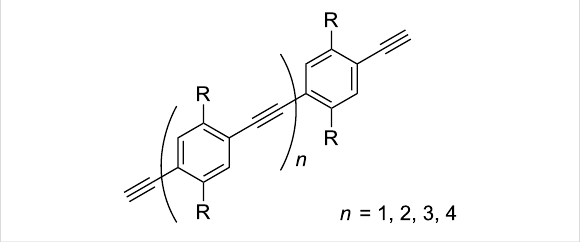
Figure 2: Generic structure of spacers containing an even ( n = 1, 3) and an odd ( n = 2, 4) number of